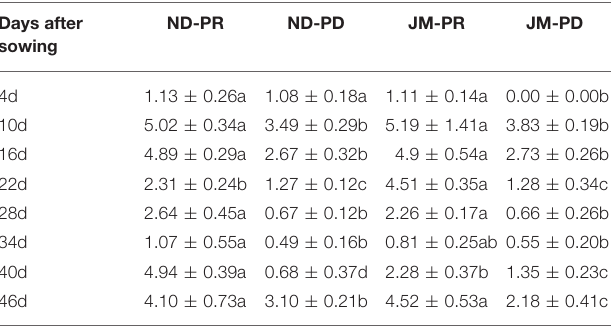
P,phosphorus;ND-PR,“NongdamianNo.10”cultivarunderrepletePconditions;ND-PD, “Nongdamian No. 10” cultivar under low P; JM-PR, “Jimian 315” cultivar under replete P conditions; JM-PD, “Jimian 315” cultivar under low P. Depicted are the means of six replicates ± standard error. For each trait, bars with the same letter are not significantly different according to Duncan’s test at a P < 0.05 threshold.